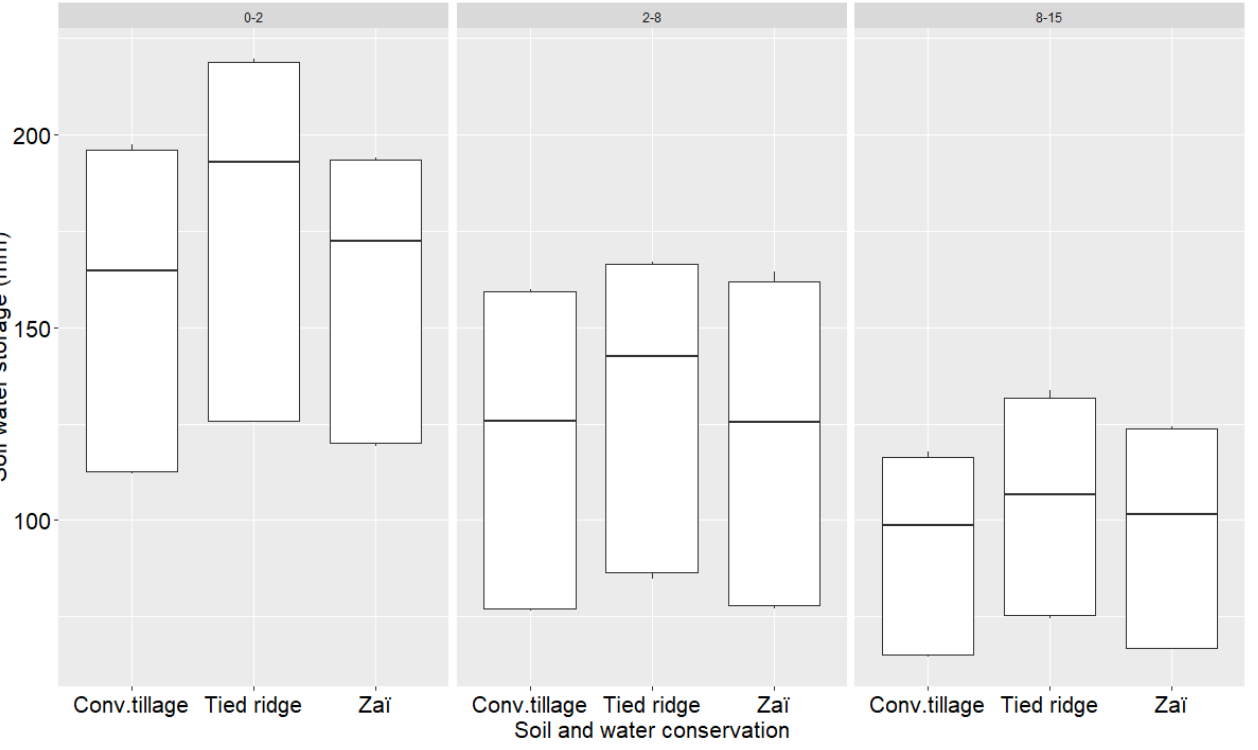
Figure 6. Variation in soil water storage among selected SWC practices along the slope gradient in the Ruzizi Plain.